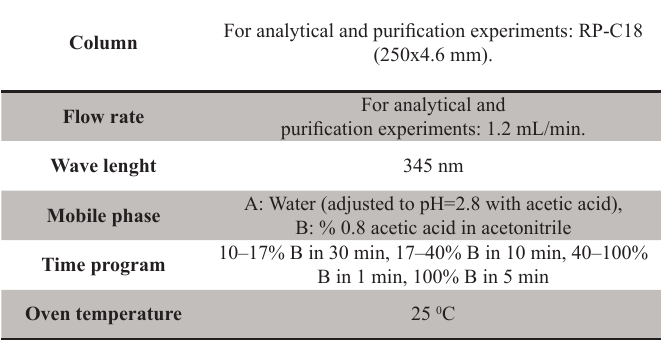
TABLE 1 - The HPLC conditions for the yarrow extract. For analytical and purification experiments: RP-C18 Column (250x4.6 mm). For analytical and Flow rate purification experiments: 1.2